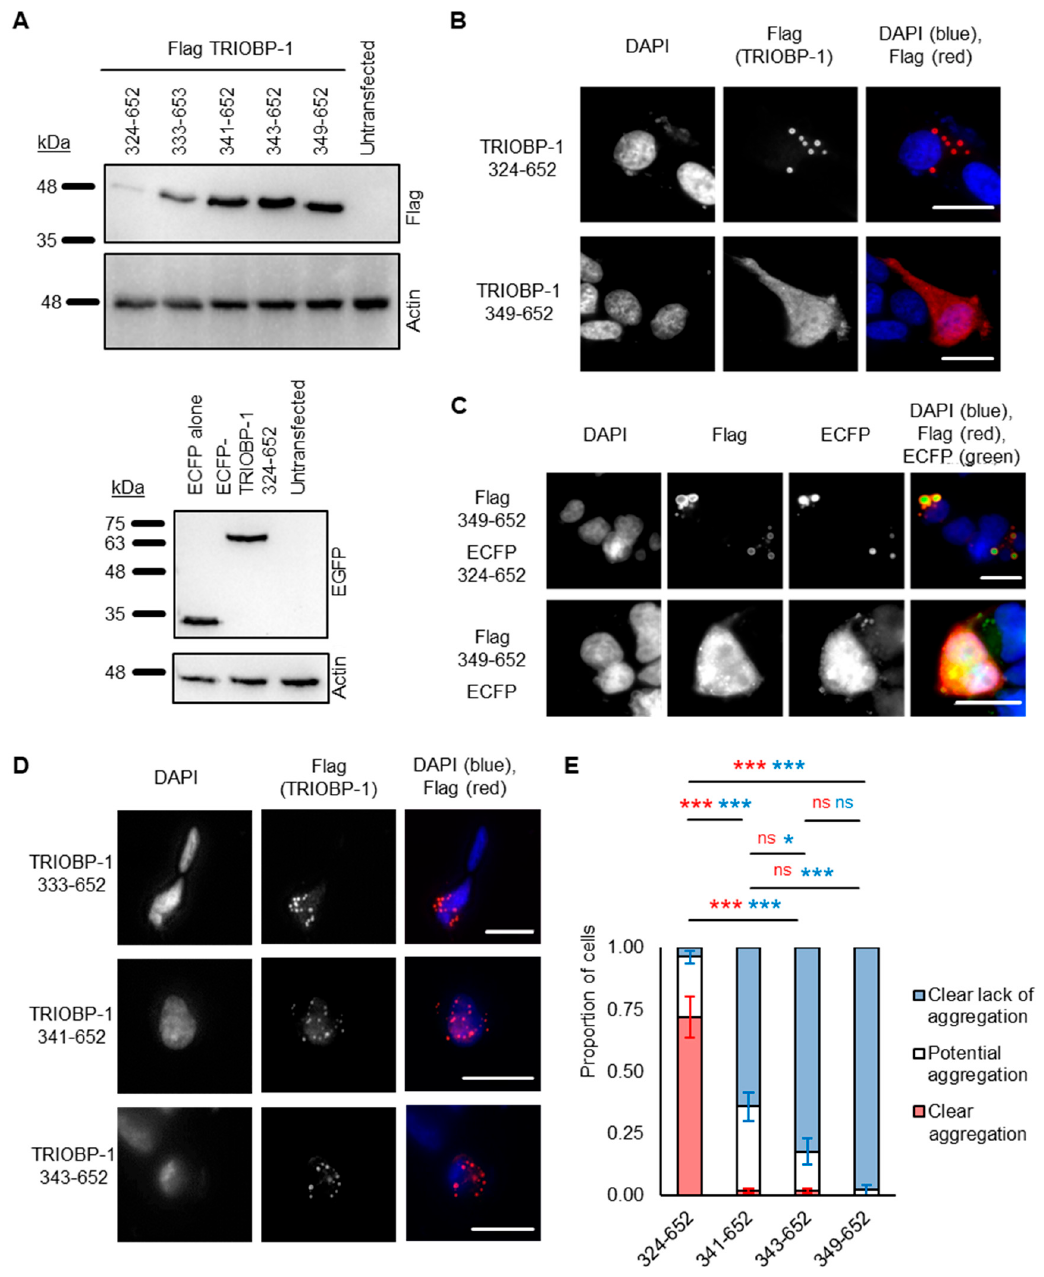
Figure 3. Testing aggregation of TRIOBP-1 using C-terminal fragments. ( A ) Western blots showing Flag-tagged TRIOBP-1 constructs (left) and ECFP or ECFP-fused TRIOBP-1 constructs (right) in HEK293 cell lysates. ( B ) A protein fragment containing amino acids (324-652) of TRIOBP-1 consis- tently forms aggregates, as expected. AA 349-652 of TRIOBP-1 consistently do not form aggregates, as expected. ( C ) When aggregating TRIOBP-1 AA 324-652 and non-aggregating TRIOBP-1 349-652 are expressed together, they co-aggregate. This does not occur due to an interaction between TRIOBP-1 349-652 and the ECFP fusion protein used. ( D ) TRIOBP-1 333-652 readily forms visible aggregates in cells, which resemble those of AA 324-652. TRIOBP-1 341-652 and 343-652 form punctate structures which are less consistent than 333-652, but may still be aggregates. ( E ) Results of a quantified, blinded experiment. AA 324-652: n = 171, AA 341-652: n = 209, AA 343-652: n = 185, AA 349-652: n = 128). For both clear aggregation (red) and clear lack of aggregation (blue): * p tukey < 0.05, *** p tukey < 0.001, ns: not significant. All cell photos show C-terminal fragments of TRIOBP-1 expressed in SH-SY5Y cells and are typical of 3 independent experiments. The scale bars represent 10 µ